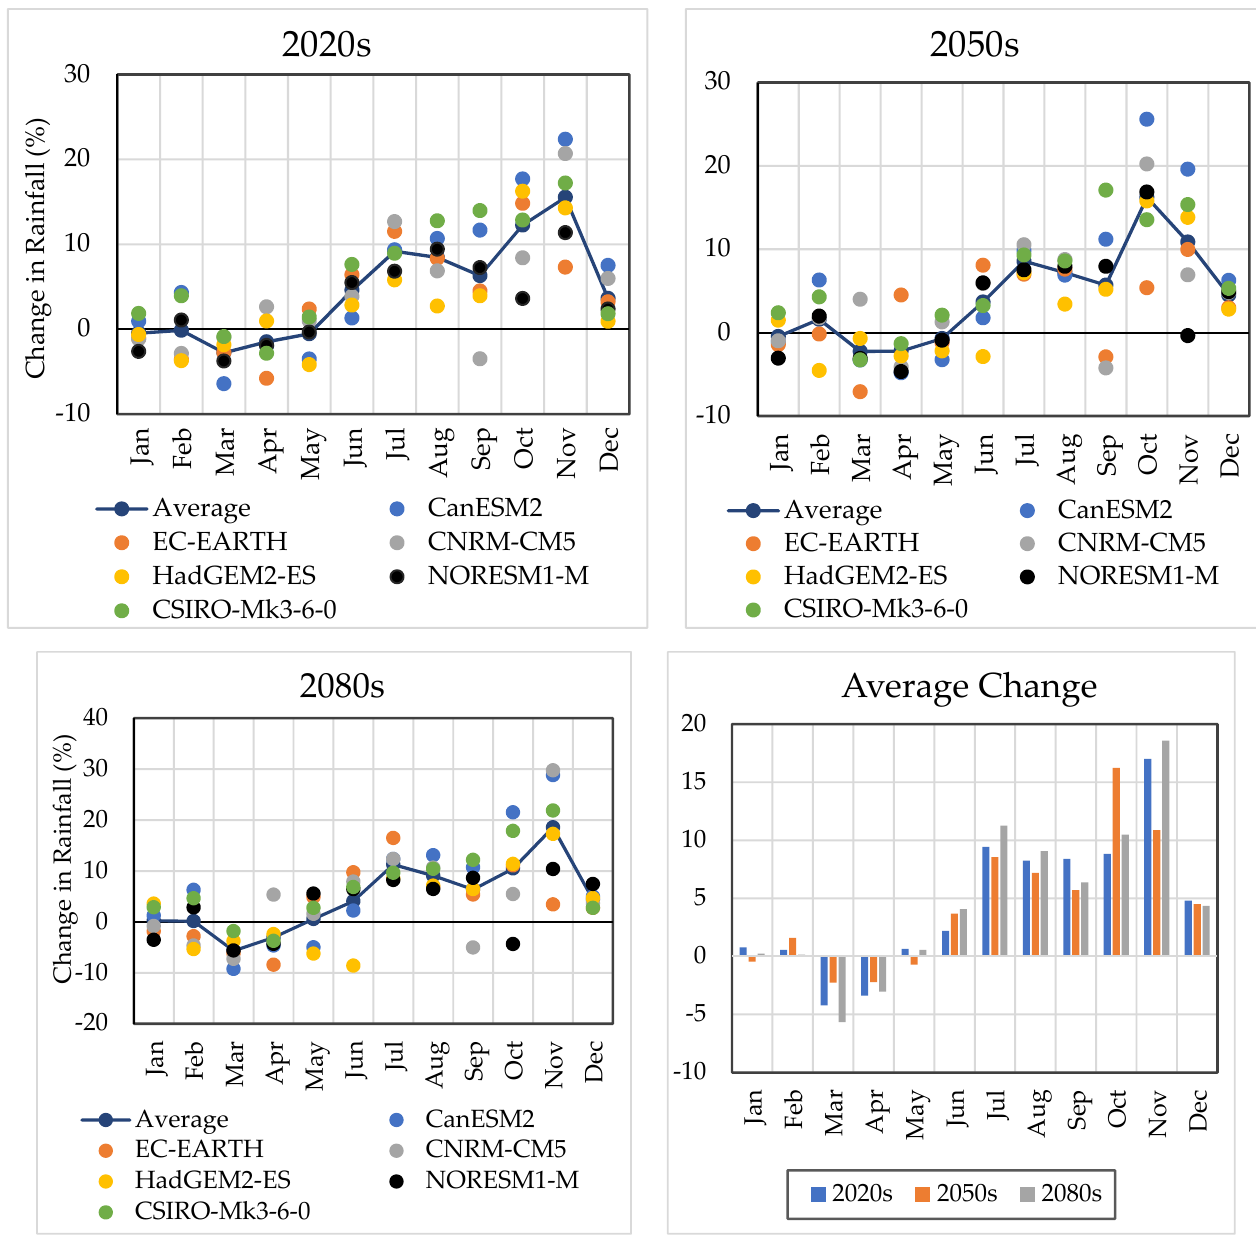
Figure 4. Rainfall change in 2020s, 2050s, and 2080s, including the average change in all climate models .